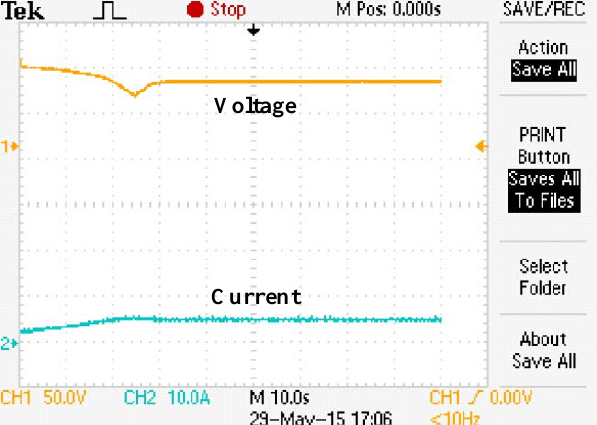
Figure 28. The performance of voltage and current for the scenarios of Figure 26 by implementing the DSMPP